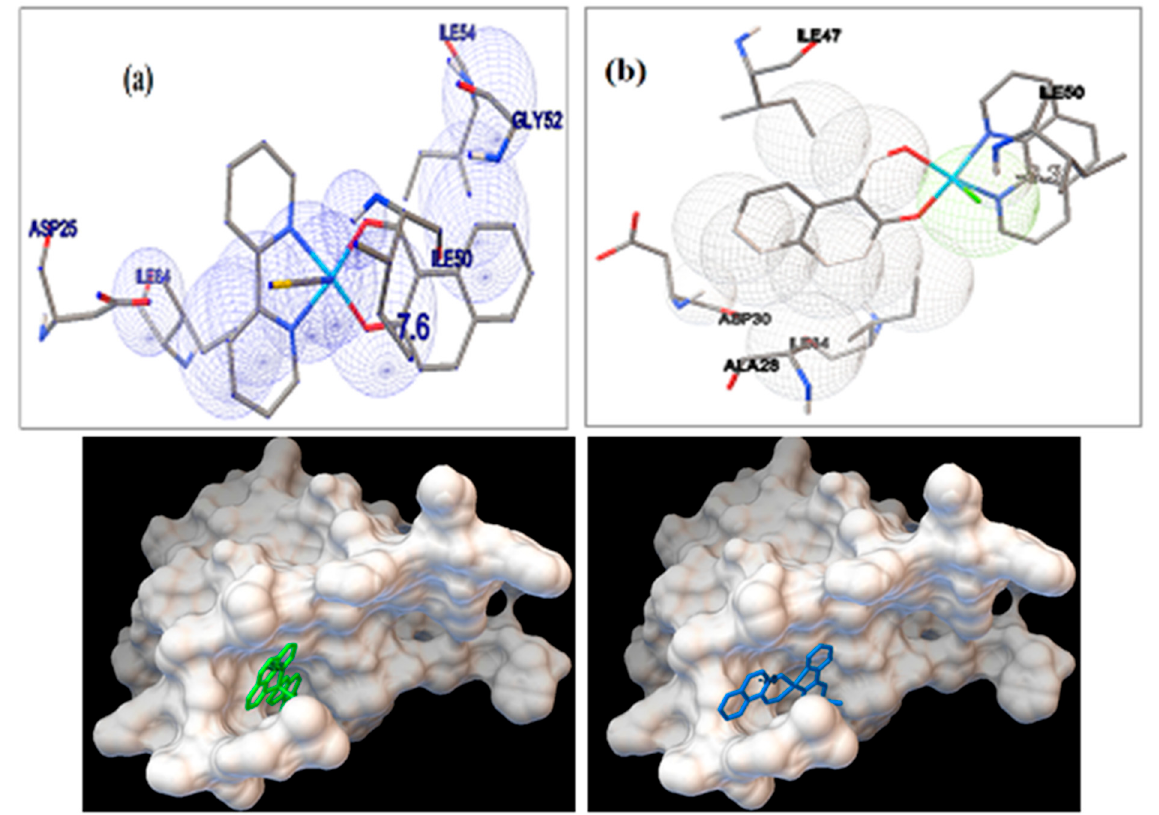
Figure 8. The upper panel shows the molecular docked model of C-1 (blue color) and C-2 (green color) in the HIV-1 protease active pocket. The enzyme is shown as a surface; the lower panel shows the best-docked conformation of C-1 ( a ) and C-2 ( b ) in the binding site of HIV-1. The estimated binding energies were − 7.6 kcal/mol for C-1 and − 7.1 kcal/mol for com-